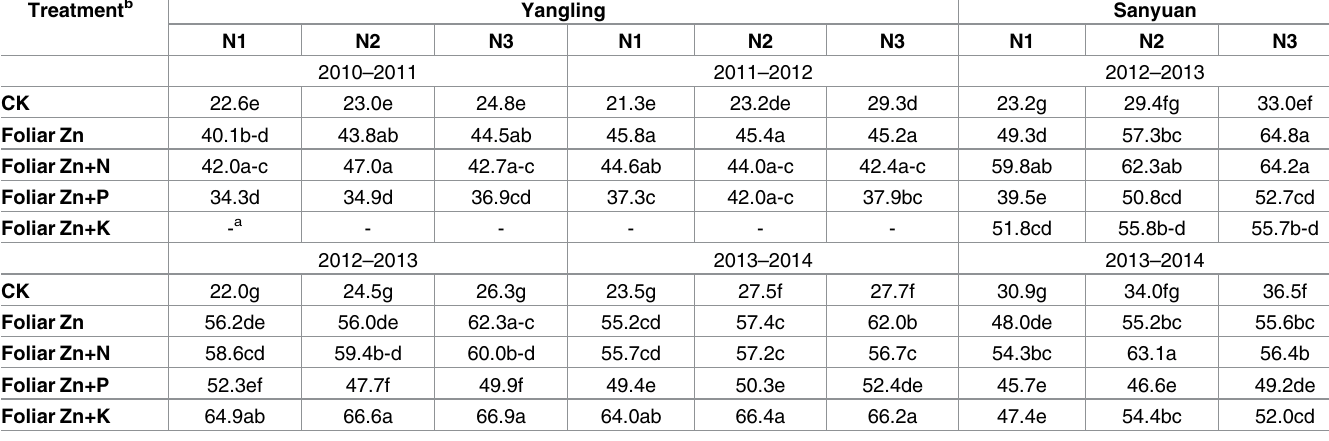
Table 2. Grain Zn concentration (mg kg -1 ) of winter wheat as influenced by soil N fertilizer rate and foliar fertilizer applications under field condi- tions at Yangling during 2010–2014 and Sanyuan during 2012–2014. Treatment